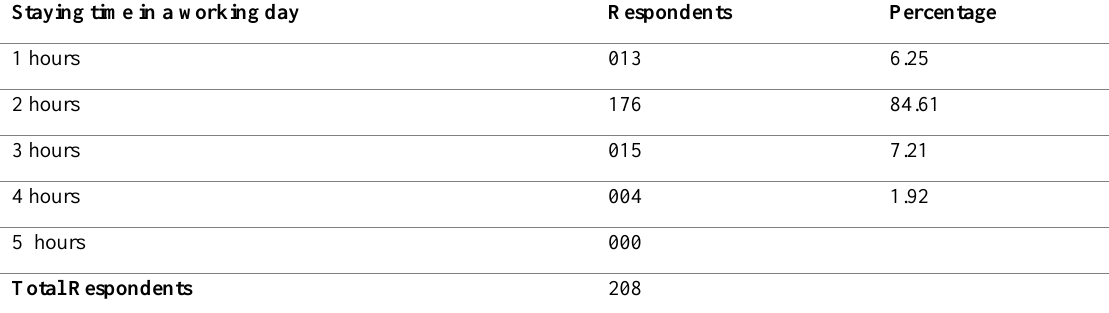
Table 4: Students staying time in